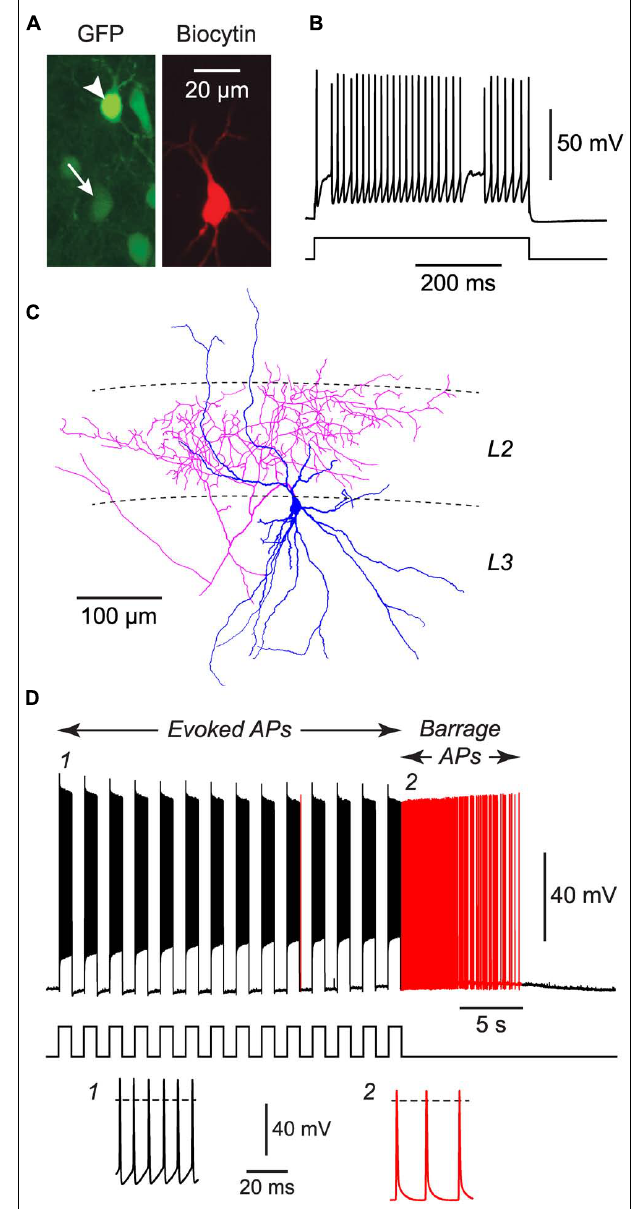
FIGURE 3 | FS cells in acute slices of the piriform cortex can also exhibit BF. (A) , Fluorescence images of the same region of a slice of piriform cortex, showing GFP label in this GAD67-GFP mouse (left) and the biocytin fill of the neuron from which recordings were made (middle).The recorded FS cell has weak GFP fluorescence (arrow, bottom), contrasting with strong GFP fluorescence in a nearby NG cell (arrowhead, top). (B) , Response of the filled FS cell in (A) to a current step (680 pA), showing its fast-spiking phenotype. (C) ,Tracing of the same cell as in (A) , showing the multipolar dendrites (blue) and dense axonal projections (red) to layer 2 ( L2 ) that are typical of FS cells in the piriform cortex (Suzuki and Bekkers, 2010a). (D) , Response of the cell in panels (A–C) to a series of current steps (1 nA for 1 s, repeated at 0.5 Hz) that eventually elicited BF (red portion of trace). Stimulus pattern is shown at bottom. Insets, bottom, show action potentials at the numbered locations in the main panel. Dashed lines, 0